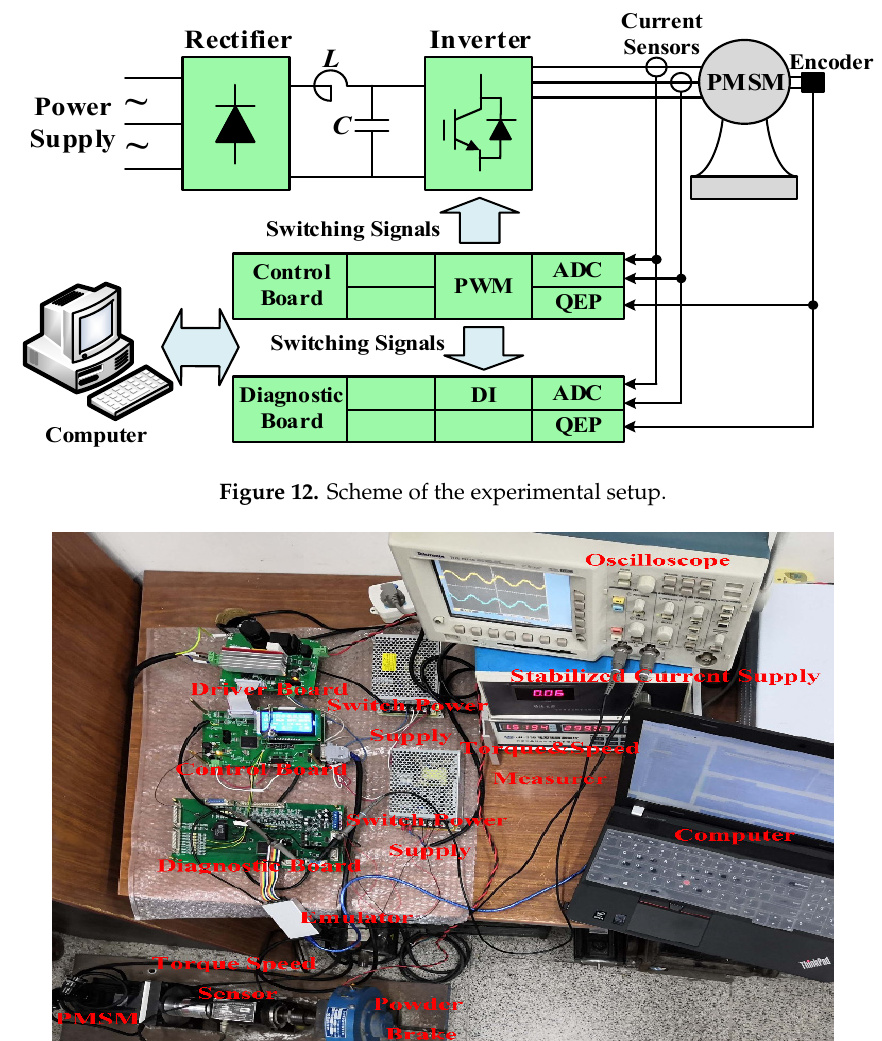
Figure 13. Photograph of the experimental setup.